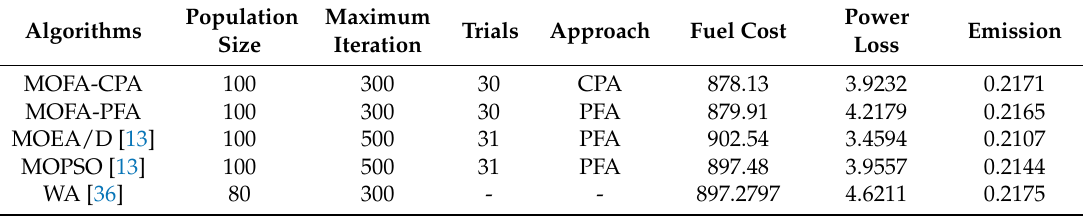
Table 7. Comparisons of the obtained BCS with other reported algorithms for Case 4.